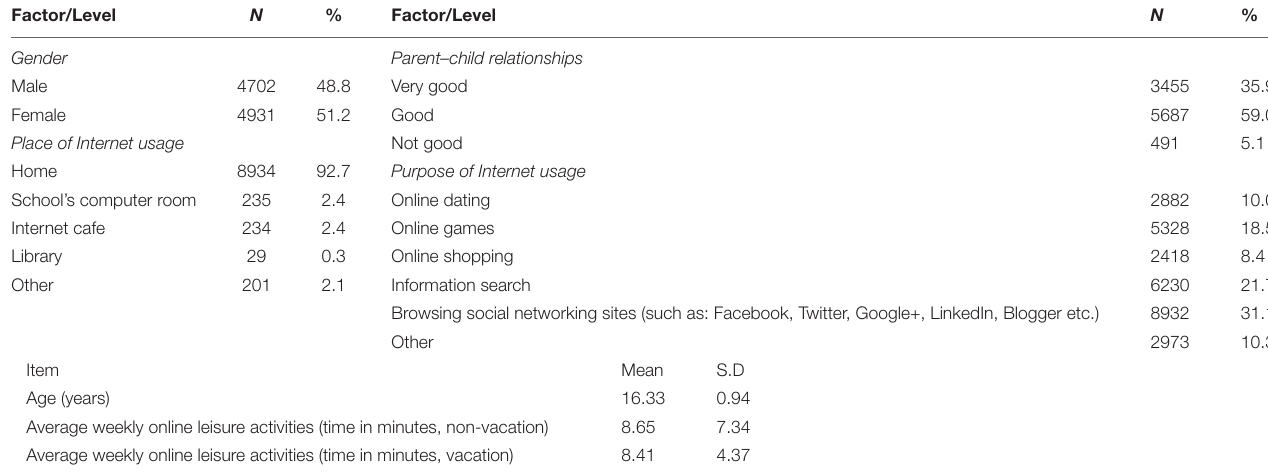
TABLE 1 | Profiles of participants ( N =